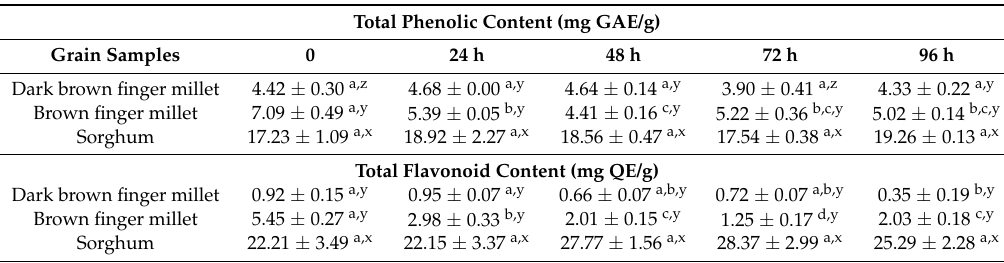
Table 3. Effect of malting period on total phenolic and total flavonoid content of finger millet and sorghum extracts obtained using 1%